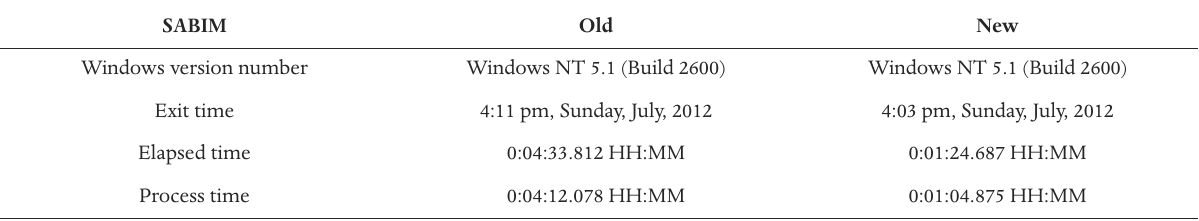
Table 4. Run times of the new and old SABIM